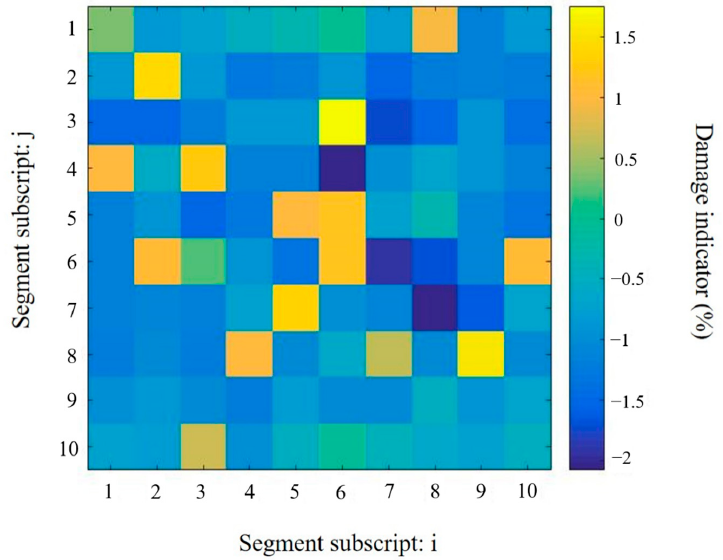
Figure 10. Damage identification results in the plate obtained using model updating with Tikhonov regularization